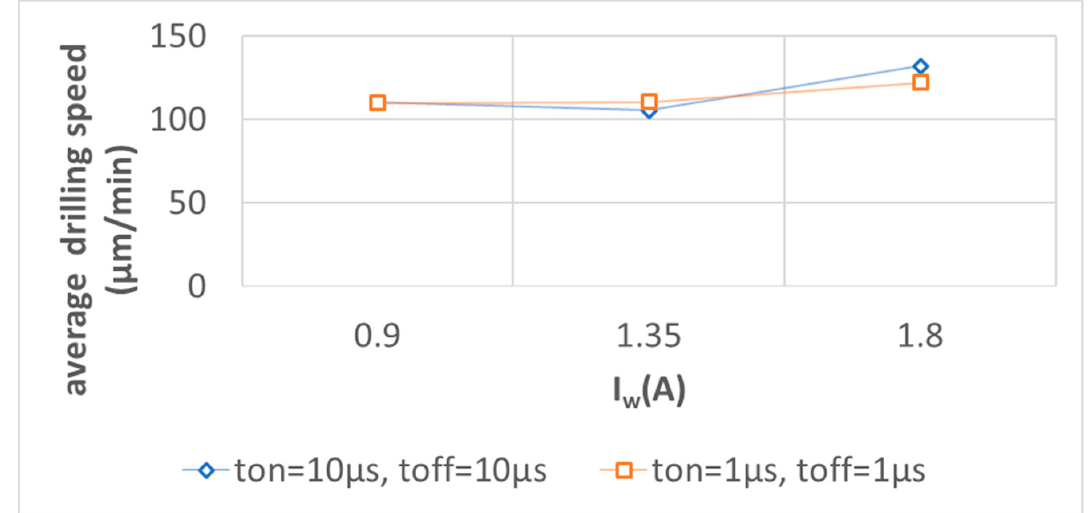
Figure 9. Figure 9. Average electrodischarge drilling speed for various t on and t o ff and working current I w .